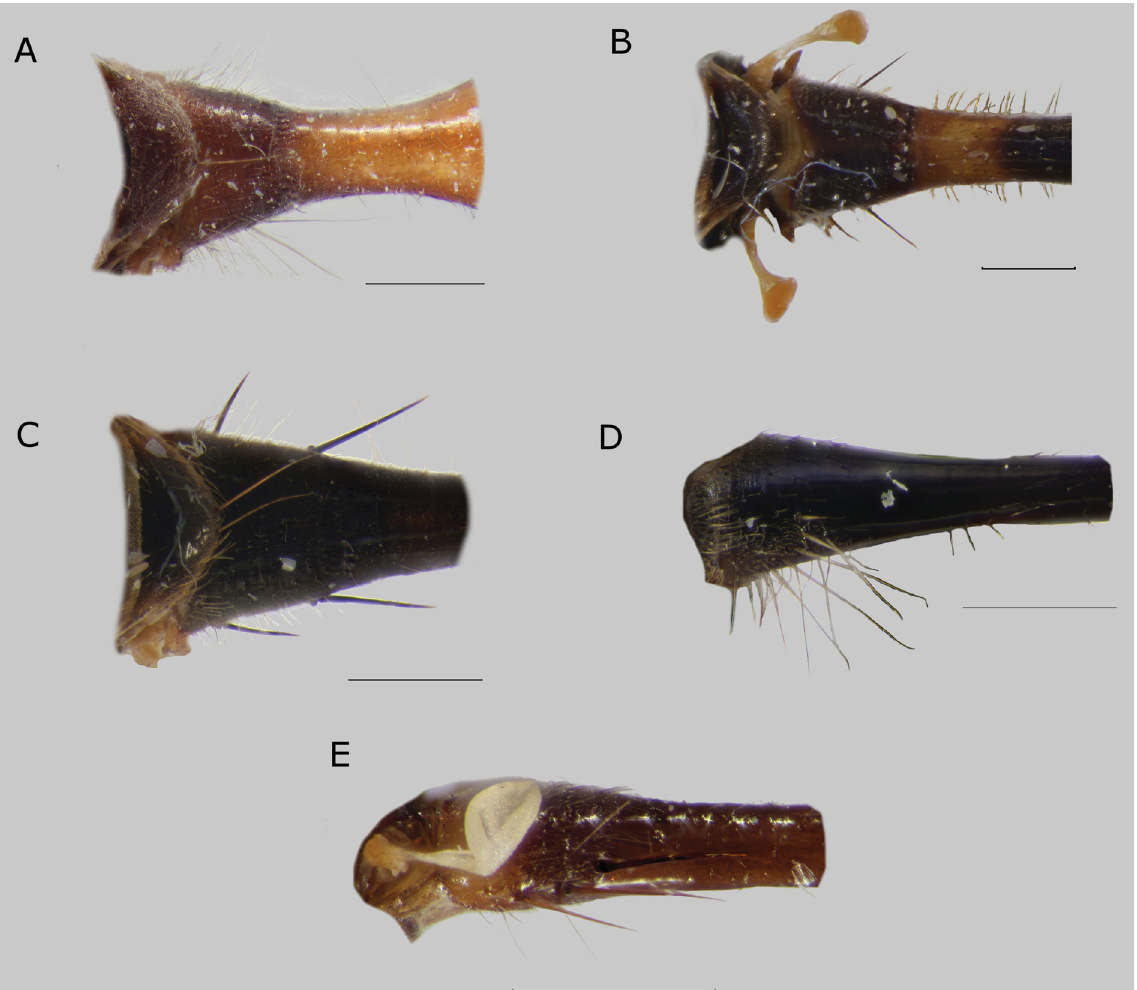
Fig. 13. Tergum I, dorsal view (A–C) and lateral view (D–E). A . Sphegina (Asiosphegina) achaeta Hippa, van Steenis & Mutin, 2015, ♀ , Myanmar. B . S. (A.) carinata Hippa, van Steenis & Mutin, 2015, paratype, ♀ , Myanmar. C . S. (A.) clavigera sp. nov., paratype, ♀ , Vietnam. D . S. (A.) crinita sp. nov., paratype, ♂ , Java. E . S. ( A. ) crucivena Hippa, van Steenis & Mutin, paratype, ♂ , Myanmar. Scale bars = 0.5